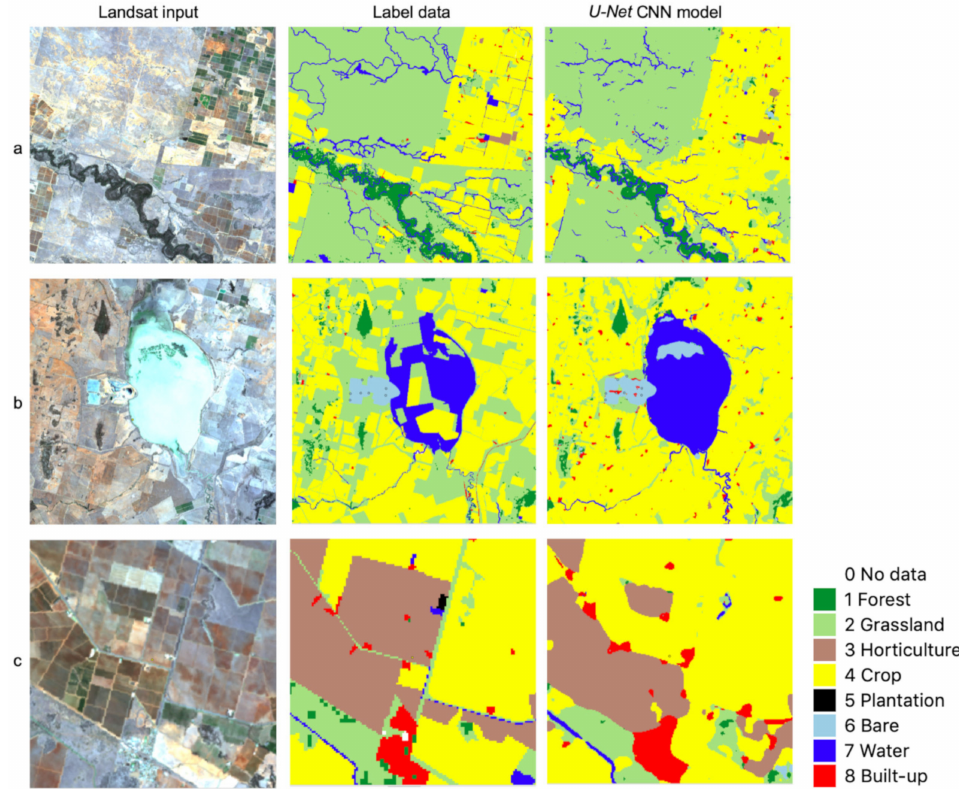
Figure 10. ( a ) Landsat input (true colour RGB), label data and U-Net CNN model for area (~28.3 km × 28.3 km) centred at 34.43 ◦ S, 145.69 ◦ E. ( b ) Results for area (~25.6 km × 25.6 km) around Lake Cowal centred at 33.63 ◦ S, 147.45 ◦ E. ( c ) Results for area (~6 km × 6 km) centred at 34.49 ◦ S, 146.18 ◦